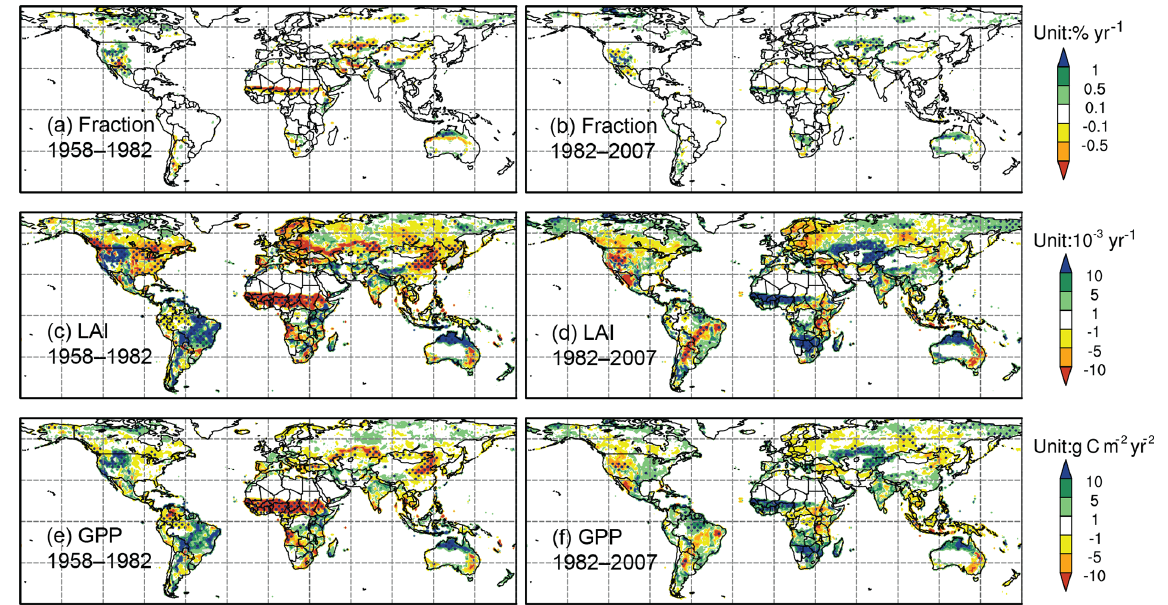
Figure 10. Same as Fig. 8 but for climate viability effect and also including the effects on fractional coverage (units: %yr − 1